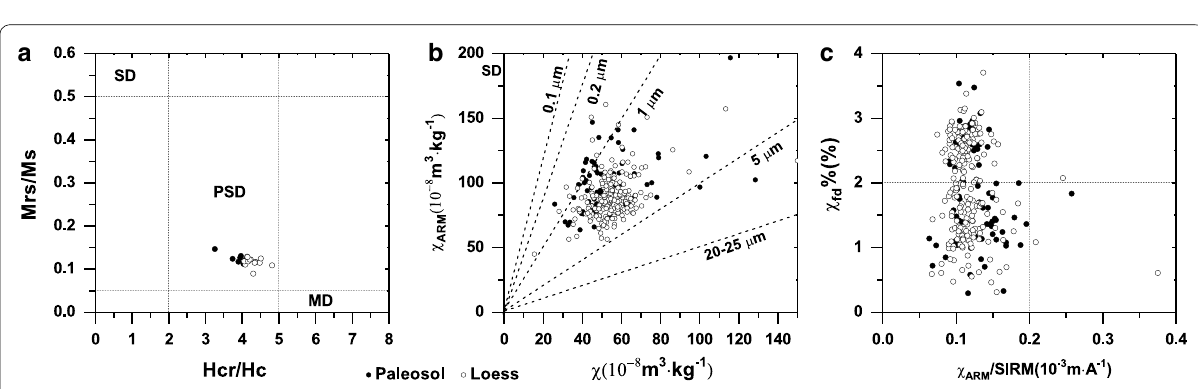
Fig. 3 a Representative samples in the Day plot; b the King plots of all samples; c results of all samples in the Dearing